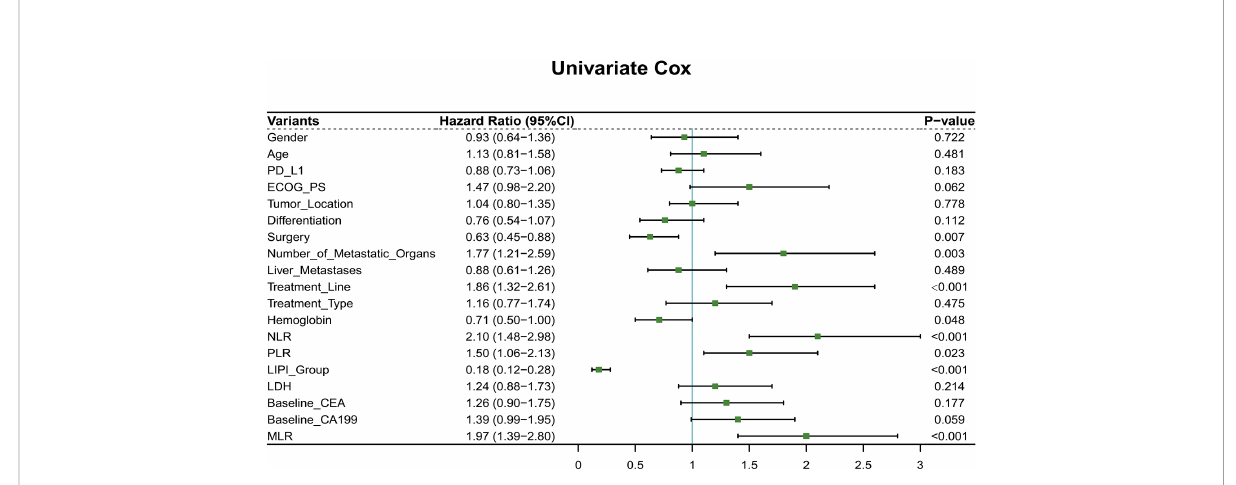
FIGURE 1 Univariate Cox regression of all features for overall survival in the training